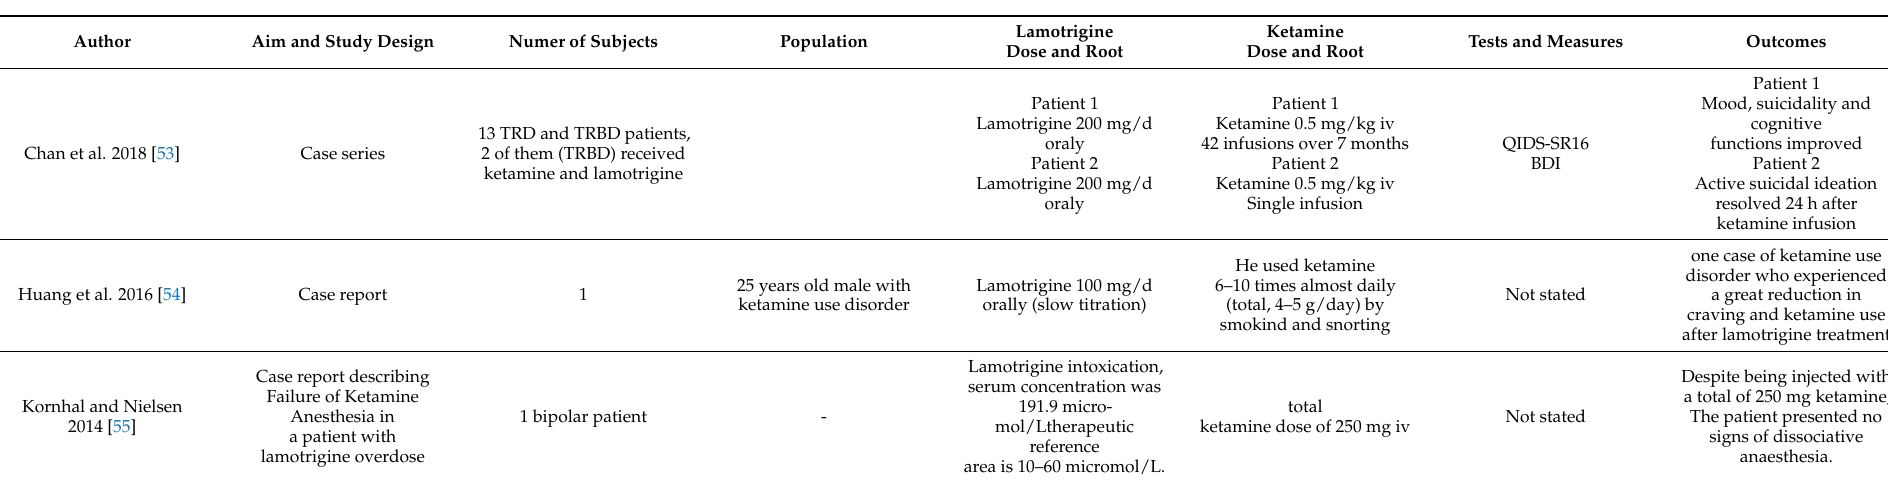
Table 5. Human studies in